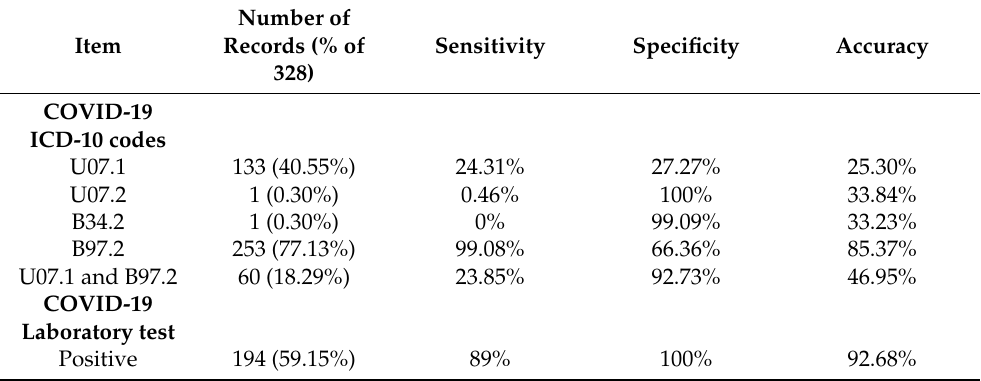
Table 4. The frequencies of using ICD-10 codes and the diagnostic accuracy between ICD-10 codes and laboratory tests for identification of confirmed COVID-19